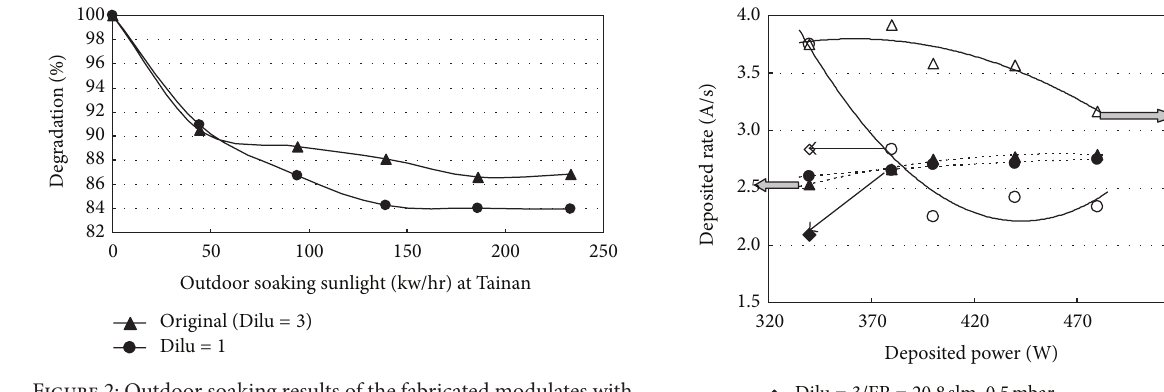
Figure 2: Outdoor soaking results of the fabricated modulates with two different hydrogen dilution ratios (i.e., 3 and 1).